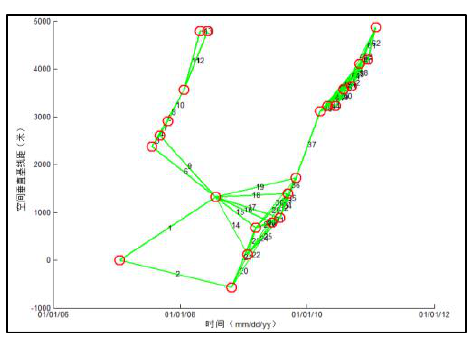
Figure 1. The small baseline spatiotemporal distribution of the first stage data